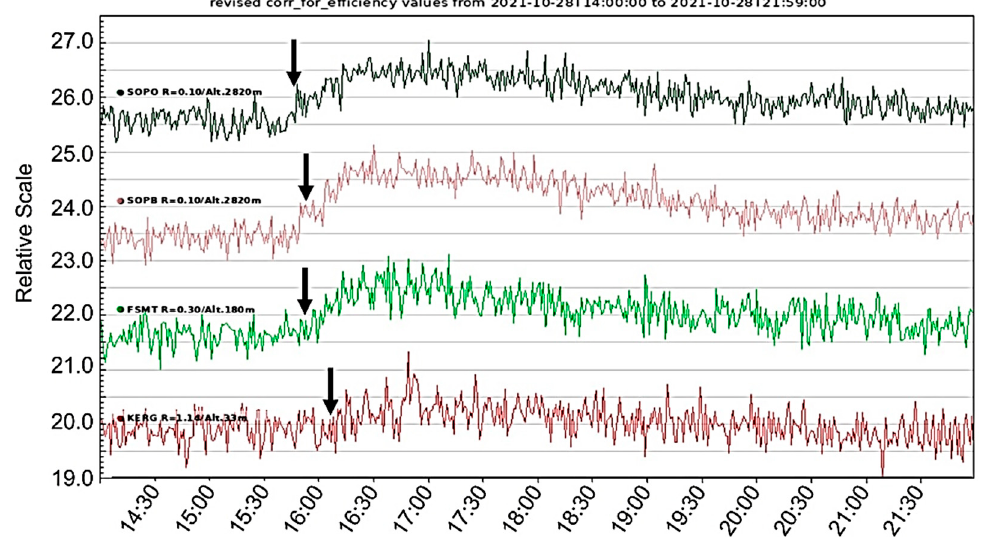
Figure 5. Cosmic ray intensity at the NM stations detected in real time during GLE73 by the A.Ne.Mo.S. GLE Alert Systems.